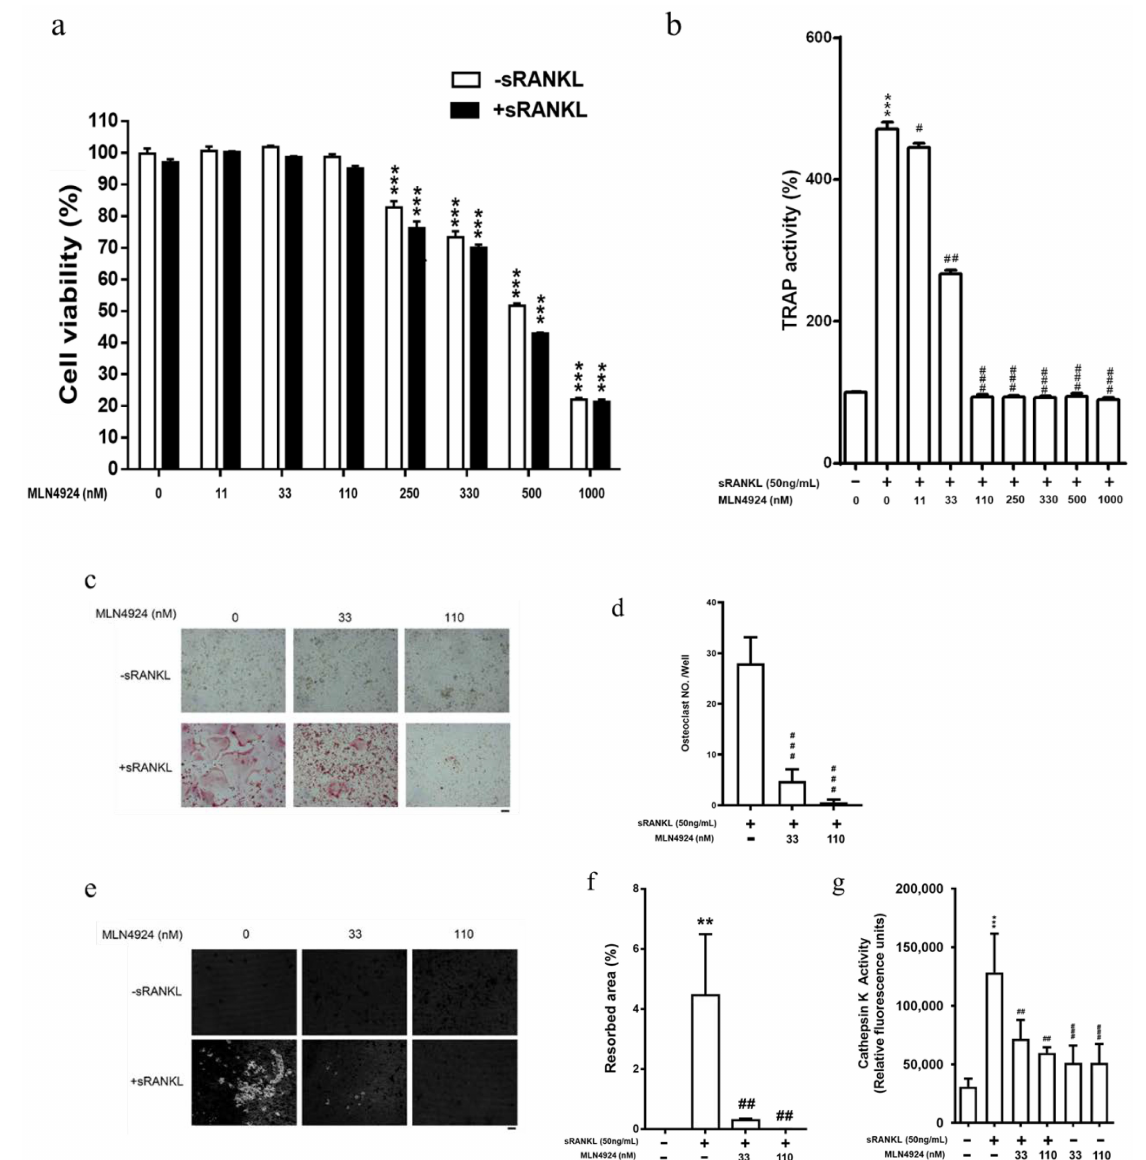
Figure 2. Effect of MLN4924 on proliferation and osteoclastogenesis in soluble receptor activator of nuclear factor- κ B ligand (sRANKL)-stimulated RAW 264.7 cells. Cells were seeded into 96-well plates, cultured with sRANKL (100 ng/mL), and indicated the concentration of MLN 4924 for 7 days. Cell proliferation assay at 48 h ( a ), *** compared with 0 nM p < 0.001. The TRAP activity was also measured ( b ), *** compared with control p < 0.001, # compared with sRANKL, p < 0.05; ## compared with sRANKL, p < 0.01; ### compared with sRANKL, p < 0.001. In 24-well plate, osteoclasts were identified through TRAP staining ( c ). The TRAP-stained positive giant osteoclasts were quantified ( d ), ### compared with sRANKL, p < 0.001. Cells were removed from the Corning Osteo Surface Assay 96-well plate and visualized with 1% toluidine blue ( e ). All photomicrographs were captured using an inverted microscope at a magnification of 100 × . Quantification of the resorbed area ( f ), ** compared with control p < 0.01; ## compared with sRANKL, p < 0.01. Cells treated with indicated groups were harvested and subjected to detection of cathepsin K activity ( g ). Scale bar represents 100 µ m. *** compared with control p < 0.001, ## compared with sRANKL, p < 0.01; ### compared with sRANKL, p <